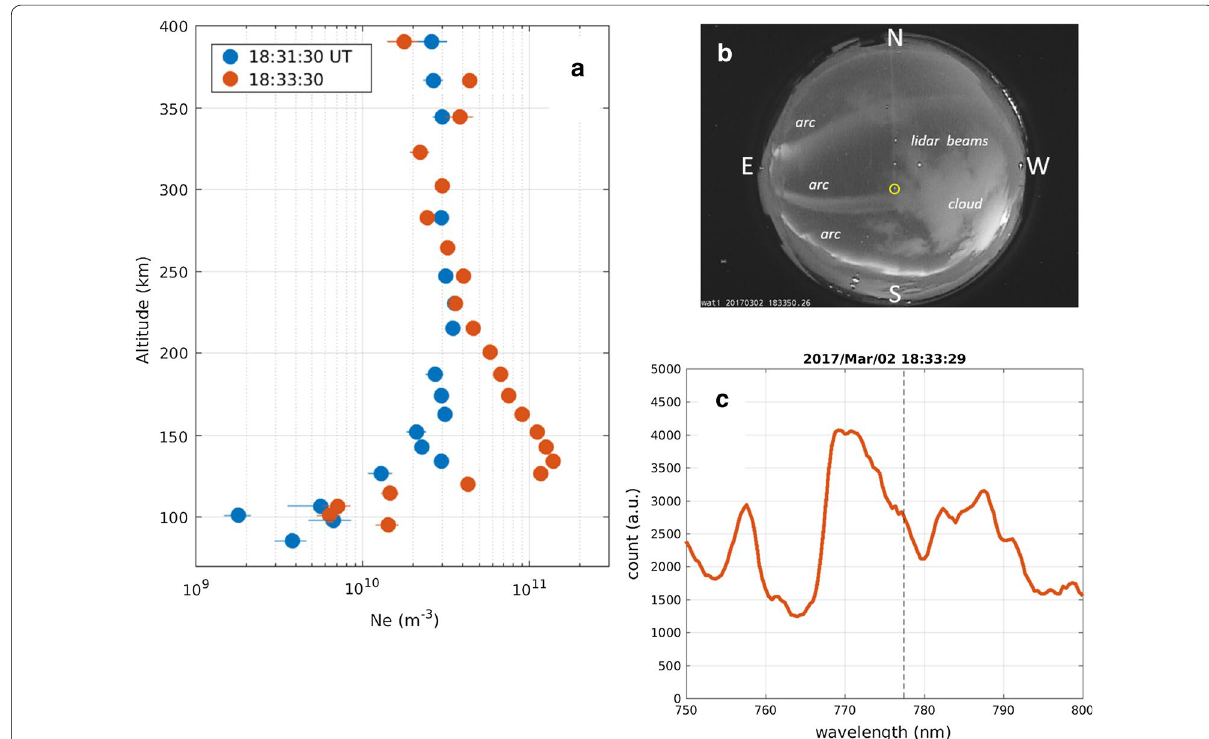
Fig. 1 a Height profiles of the EISCAT‑measured electron density at 18:31:30 UT (blue) and 18:33:30 UT (orange) on March 2, 2017. Measurement uncertainty of 1 σ is marked by a horizontal bar in each color. b An image of the Tromsø all‑sky camera, which was taken at 18:33:50 UT. The ± direction of the EISCAT radar and spectrograph measurements is marked by a yellow circle. Five faint lines from the northern edge represent contaminations of a sodium lidar. c Spectrum measured at 18:33:29 UT on March 2, 2017, at wavelength of 750–800 nm. A vertical dashed line is marked at 777.4 nm